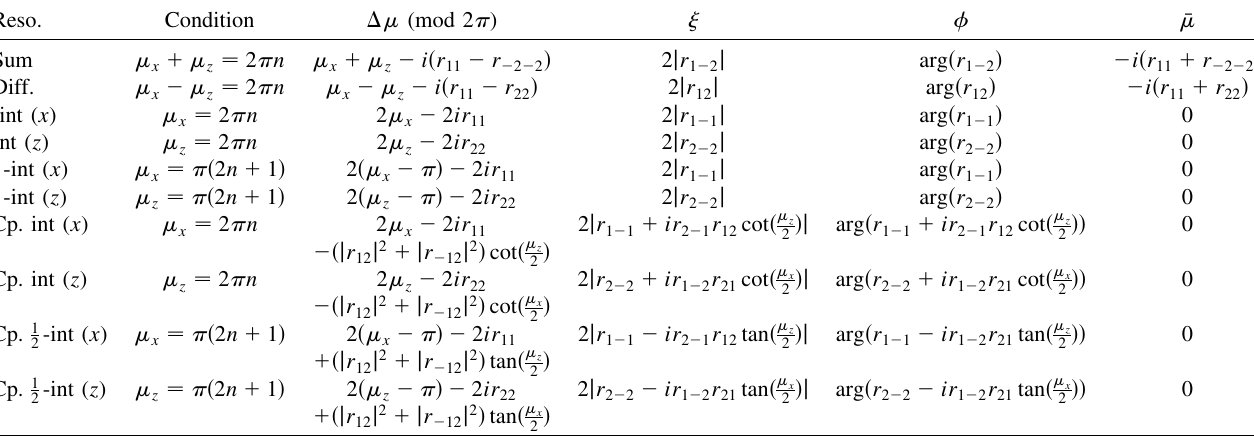
here are r , i.e., the part of r coming from the coupling jk jk(cid:4) jk coming from the difference from resonance jk(cid:6) and (cid:6) . The resonances with the abbreviation ‘‘Cp.’’ refer to the full 2nd order x z